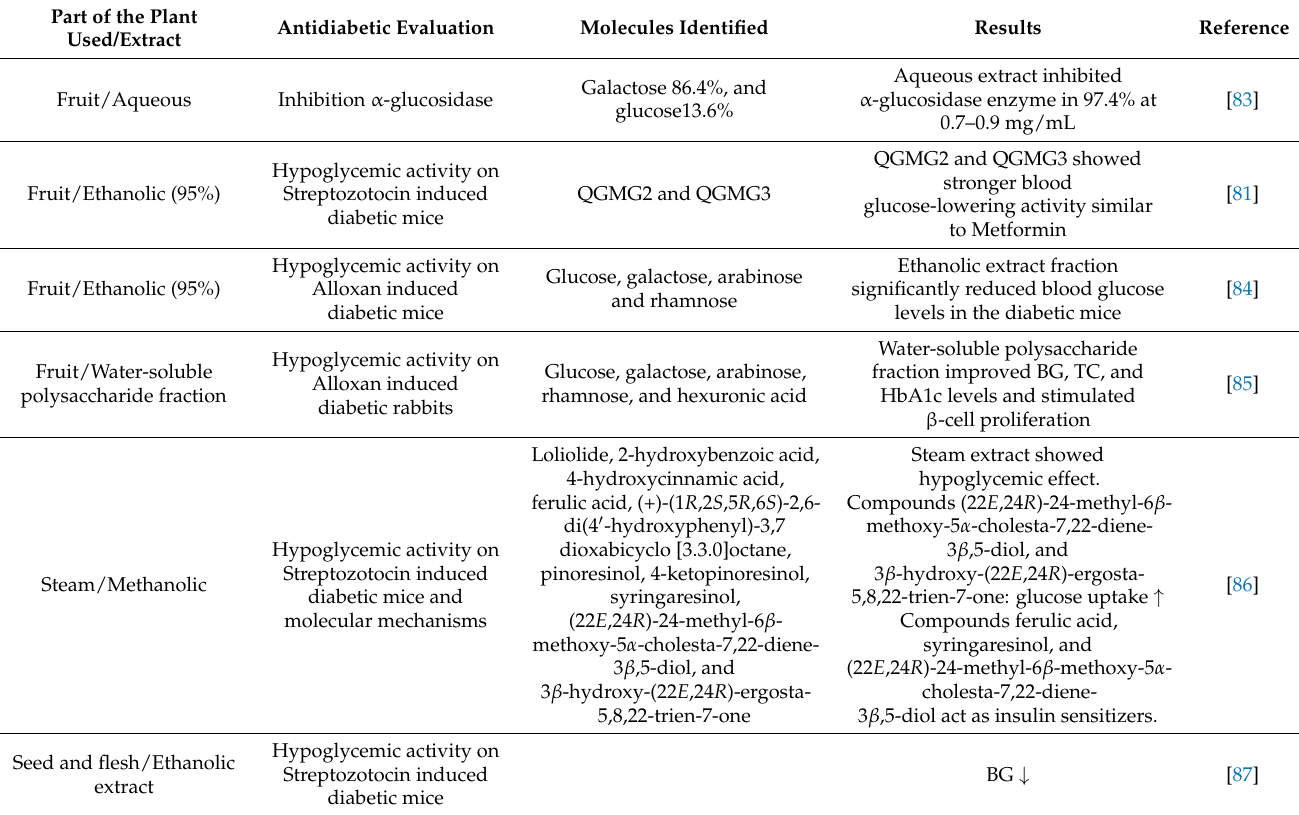
Table 2. Antidiabetic activity of extracts prepared with different plant organs of C. moschata